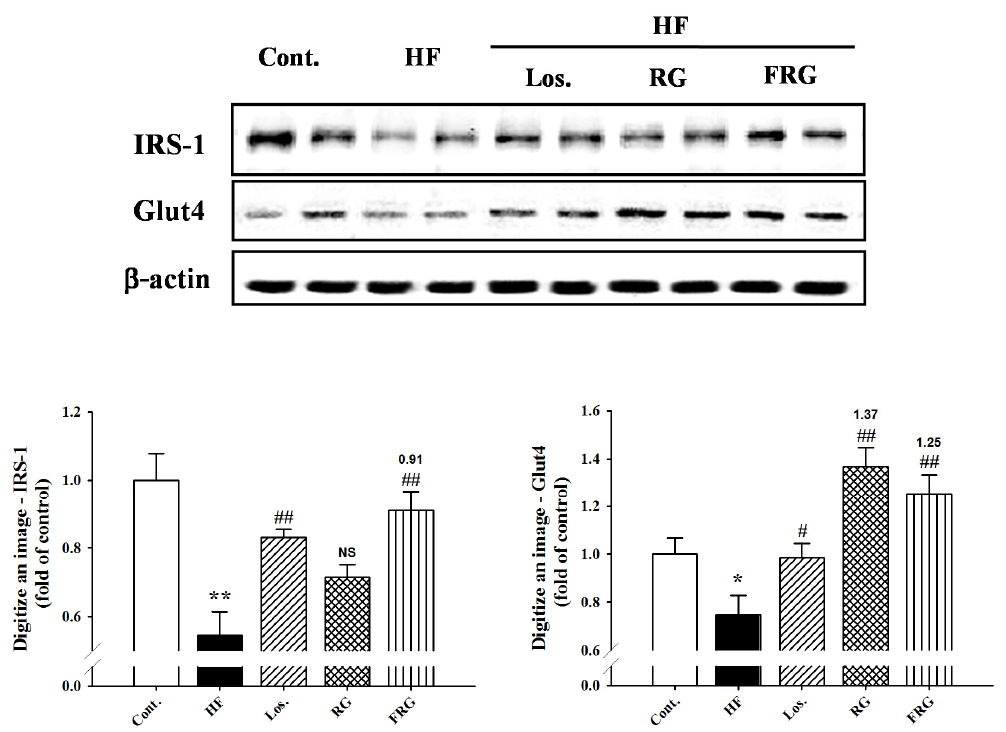
Figure 8. Effect of FRG on the expression of IRS-1 and Glut4 in the muscle of HF diet rats. Each electrophoretogram is representative of the results from three individual experiments. Values were expressed as mean ± S.E. ( n = 3). ** p < 0.01 versus Cont.; ## p < 0.01 versus HF. Abbreviations: HF, high fructose; HF + Los., high fructose diet with losartan; HF + RG, high fructose diet with red ginseng; HF + FRG, high fructose diet with fermented red ginseng.